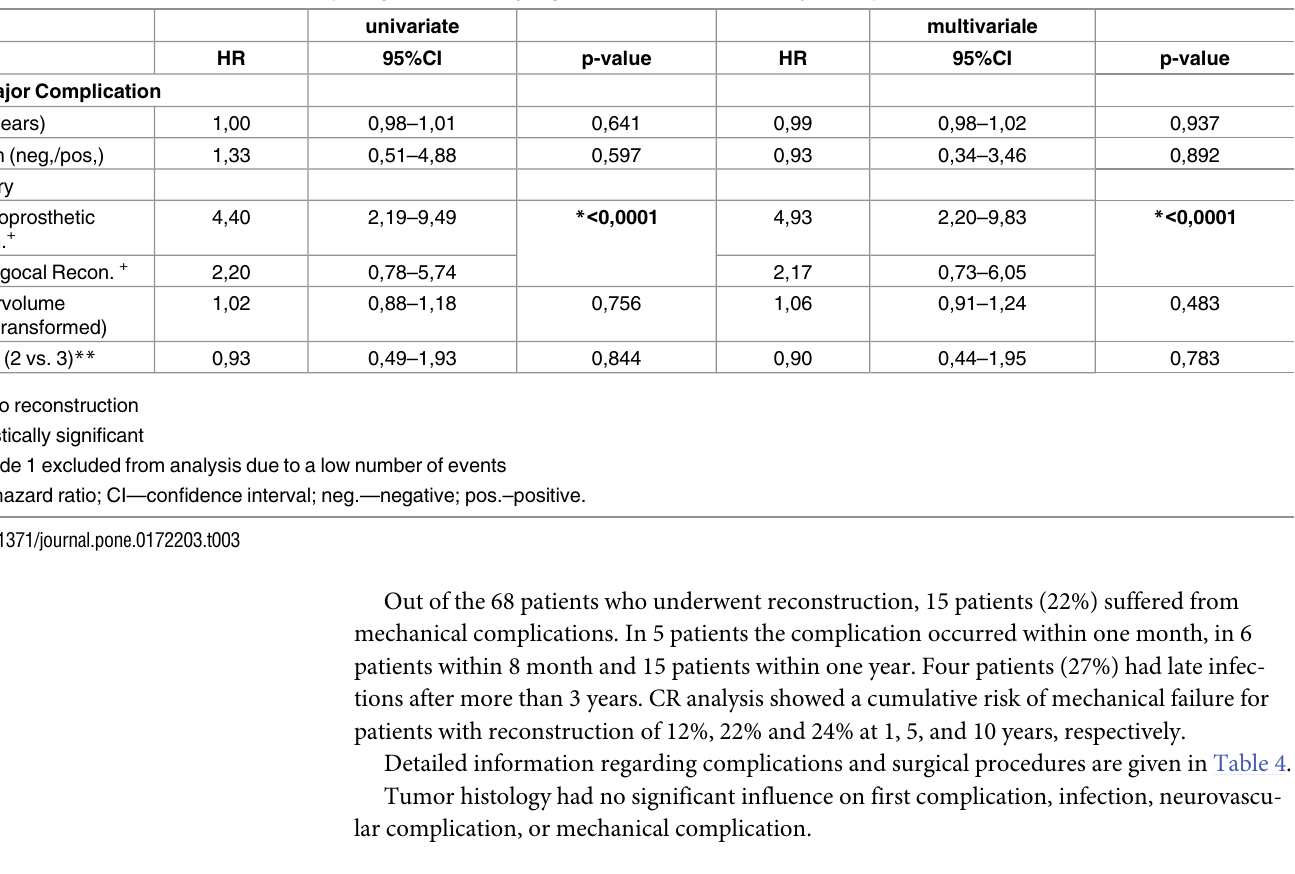
Table 3. Univariate and multivariable competing risk Fine-Gray regression models for 1st major